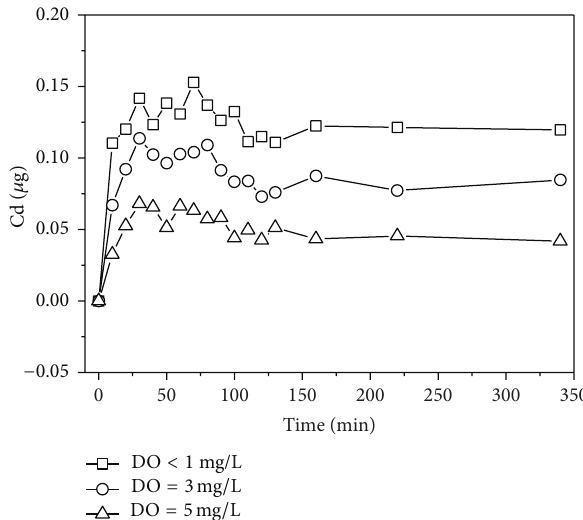
Figure 5: The amount of cumulative release of Cd from sediments changed with